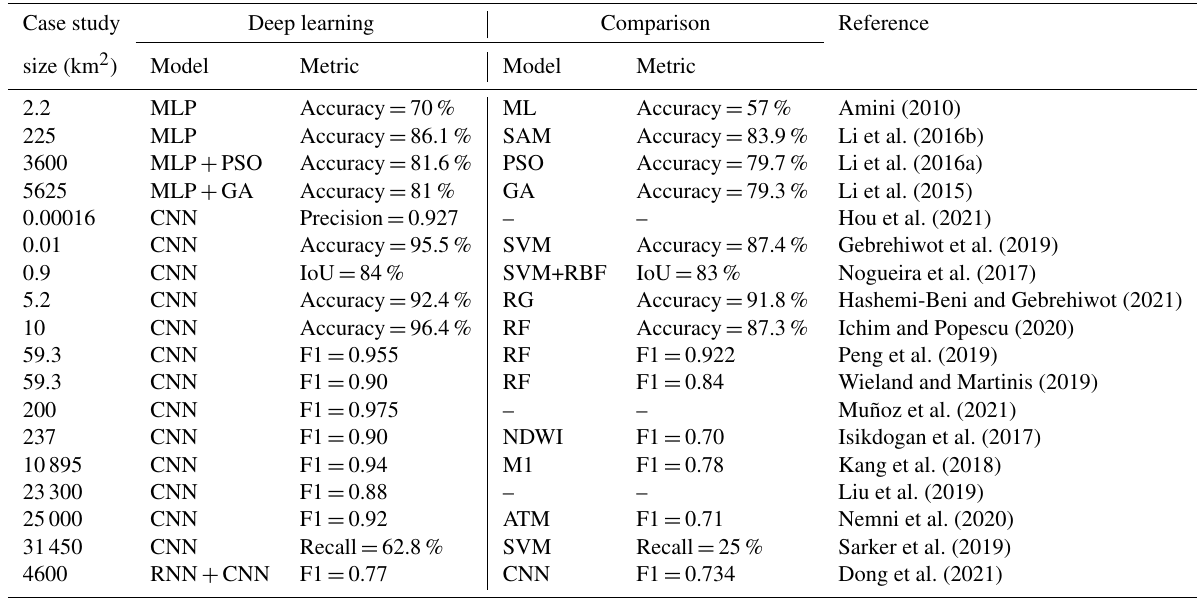
Table 3. Performance of the deep learning and comparison with reference models for flood inundation. Case